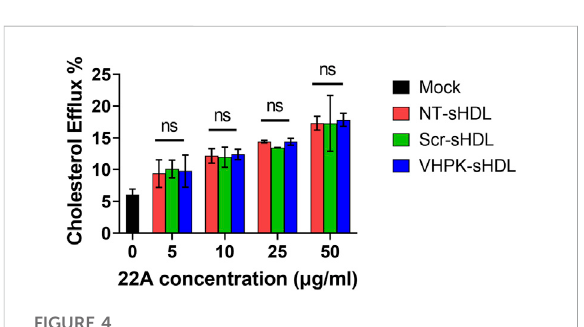
FIGURE 4 Cholesterol ef fl ux capacity of sHDLs on 3 H-cholesterol laden J774. A1 cells ( n = 3, mean ±